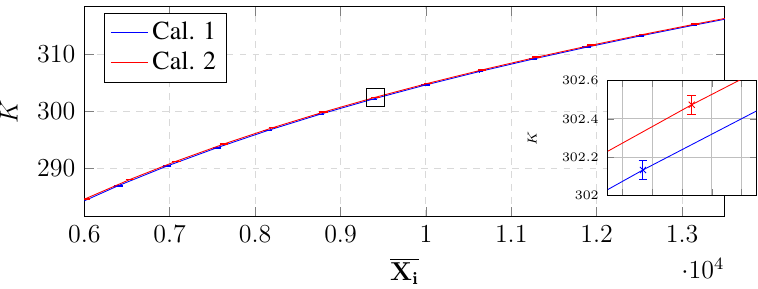
Figure 6. Results from two different calibrations with different lens focal settings.